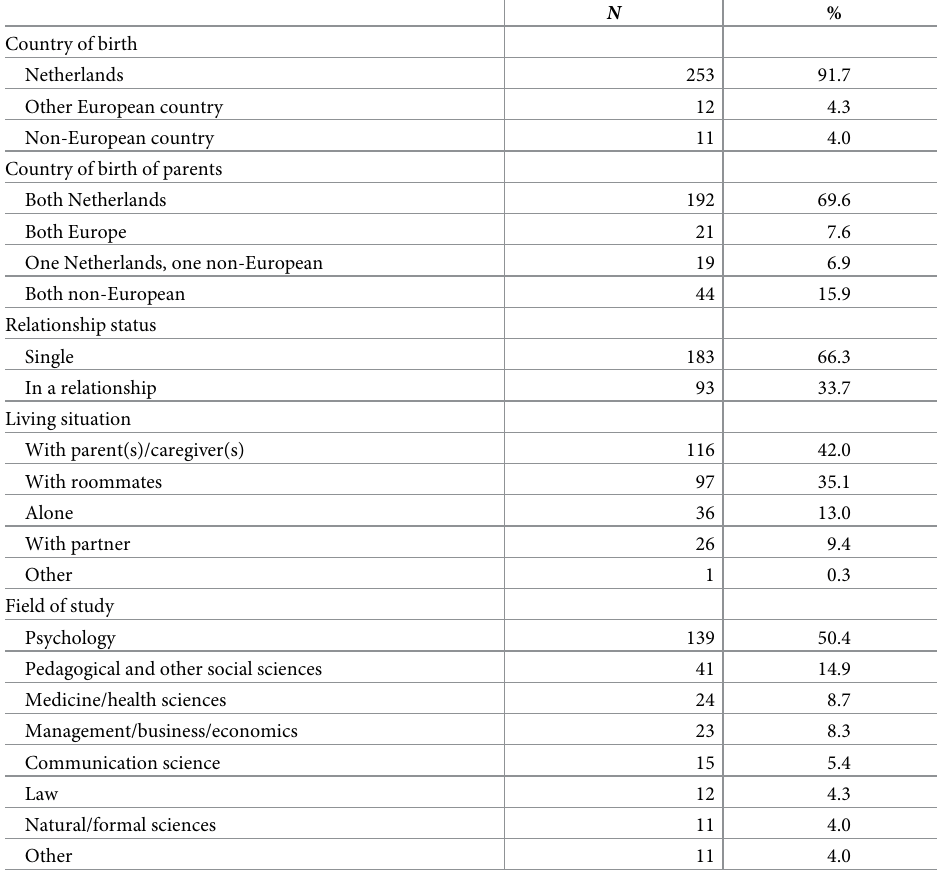
Table 1. Demographic characteristics of the total study sample ( N =